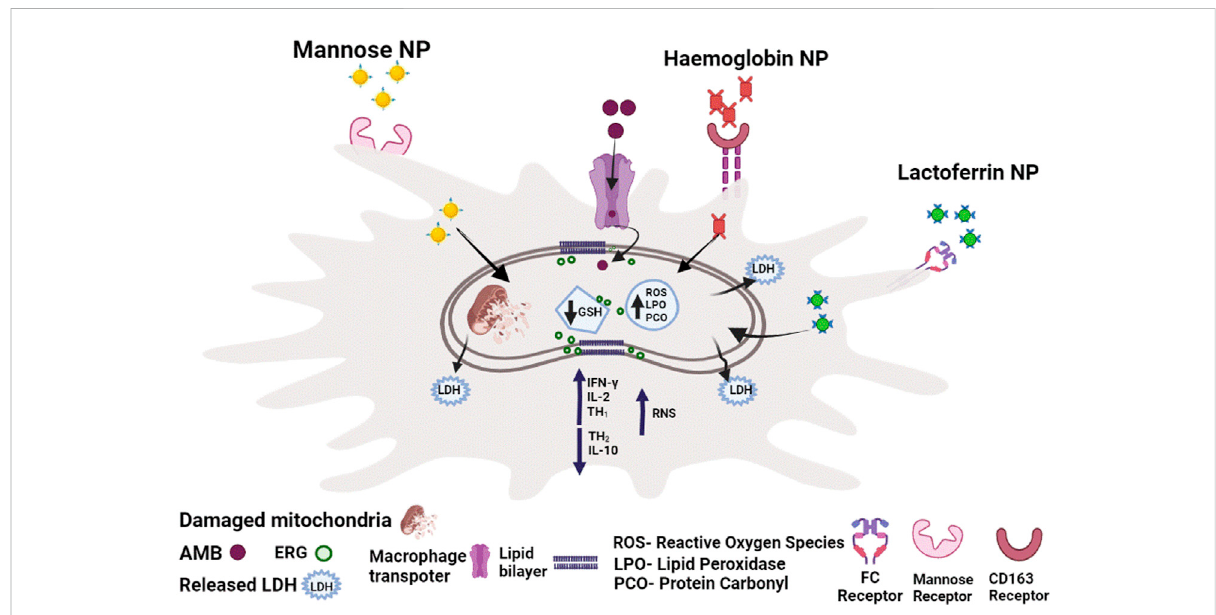
FIGURE 1 The mechanism of action of AmB against promastigotes and intracellular amastigotes. Depletion of ergosterol, membrane damage with LDH release, disruption of redox homeostasis with reduced thiol content in promastogtes and increased RNS production along with increased Th1/ decreased Th2 response in amastigotes re fl ects AmB-mediated